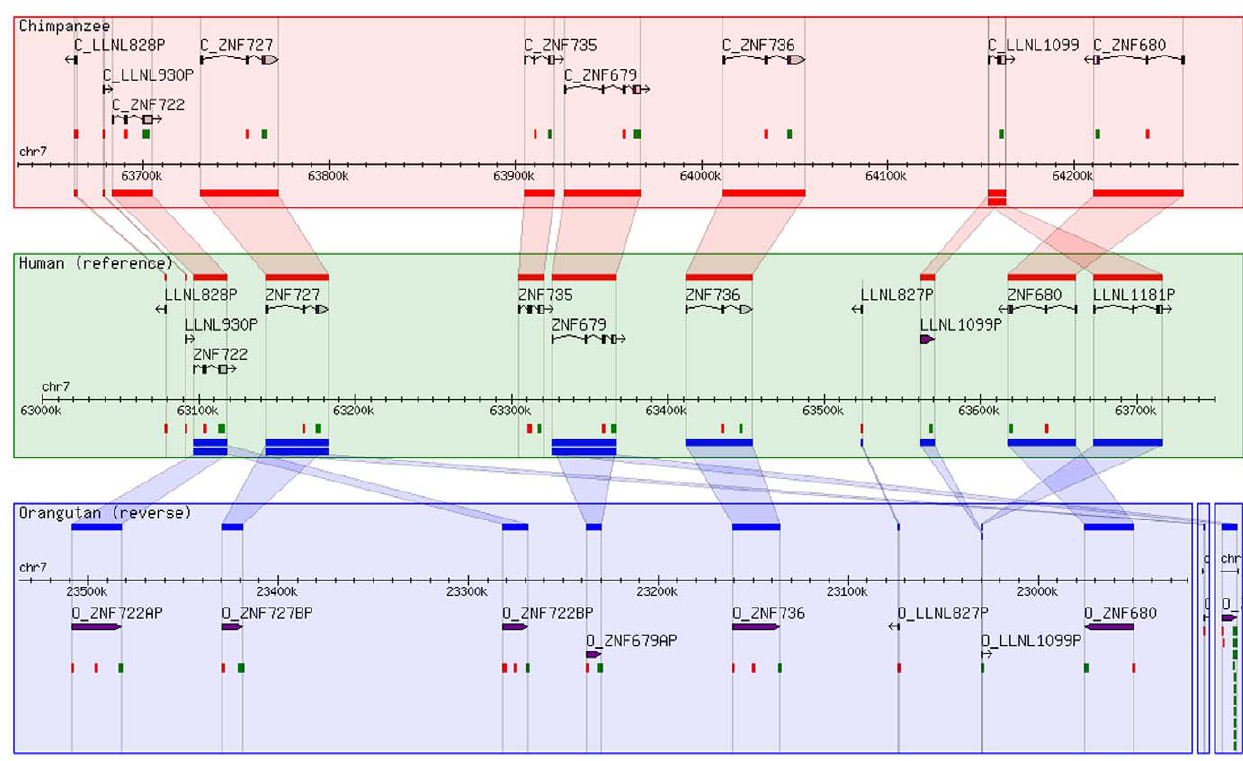
Figure 2. An example of a gene cluster with species-specific loci. Human (cluster chr7q11.21b, region, human chromosome 7:63000000– 63750000) was chosen as the reference for this Gbrowse display. Loci are depicted by rectangles. Orthologous loci are connected by lines. Colors indicate the species comparison: Red for human-chimpanzee and blue for human-orangutan. The human-rhesus macaque comparison is not shown, but can be viewed on our synteny browser (http://znf.igb.illinois.edu/cgi-bin/gbrowse_syn/znf_synteny/). Continuous stretches of chromosomes are shown in a box; orthologs located on other chromosomes (e.g. random chromosomes) are shown in separate boxes. Note the paralogs LLNL1099P and LLNL1181, an example for a human specific duplication, and ZNF722 , an example for a gene duplicated in orangutan. Further note that for orangutan the reverse is shown, indicating an inversion on the lineage to humans and chimpanzees; the orangutan gene order is likely to be ancestral because it is shared by rhesus macaque (not shown).